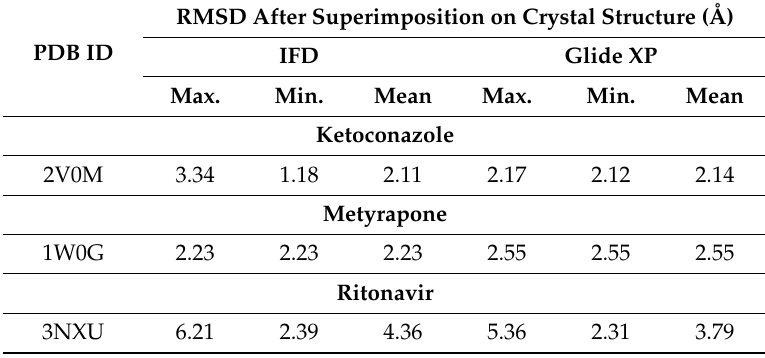
Table 2. Superimposition of ligands after docking over the corresponding crystal structure of CYP3A4. RMSD After Superimposition on Crystal Structure (Å) PDB ID IFD Glide XP Max. Min. Mean Max.